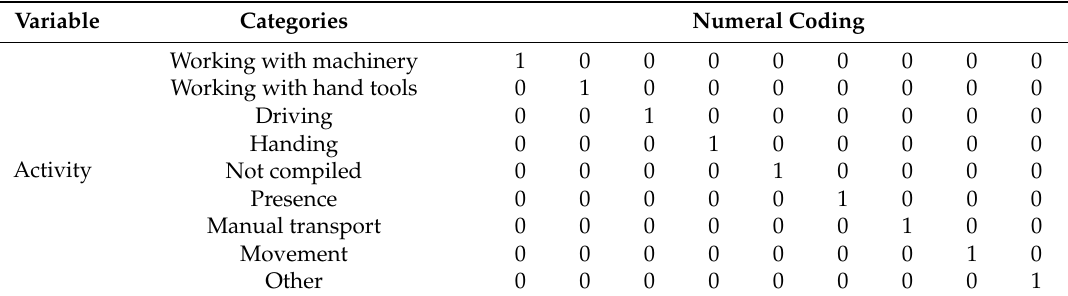
Table A1. Coding table for ESAW